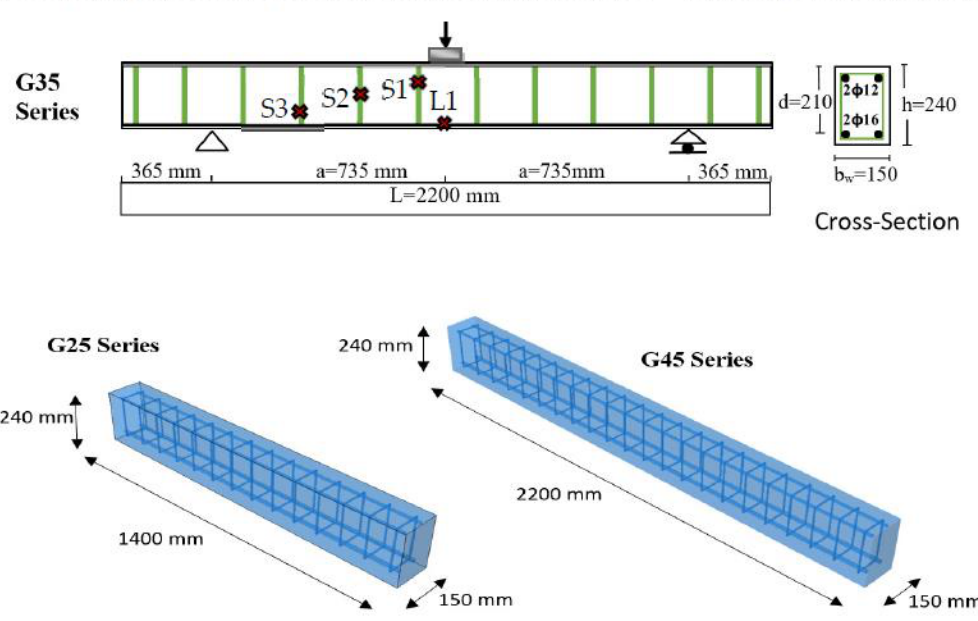
Figure 3. Test set-up and reinforcement configuration.